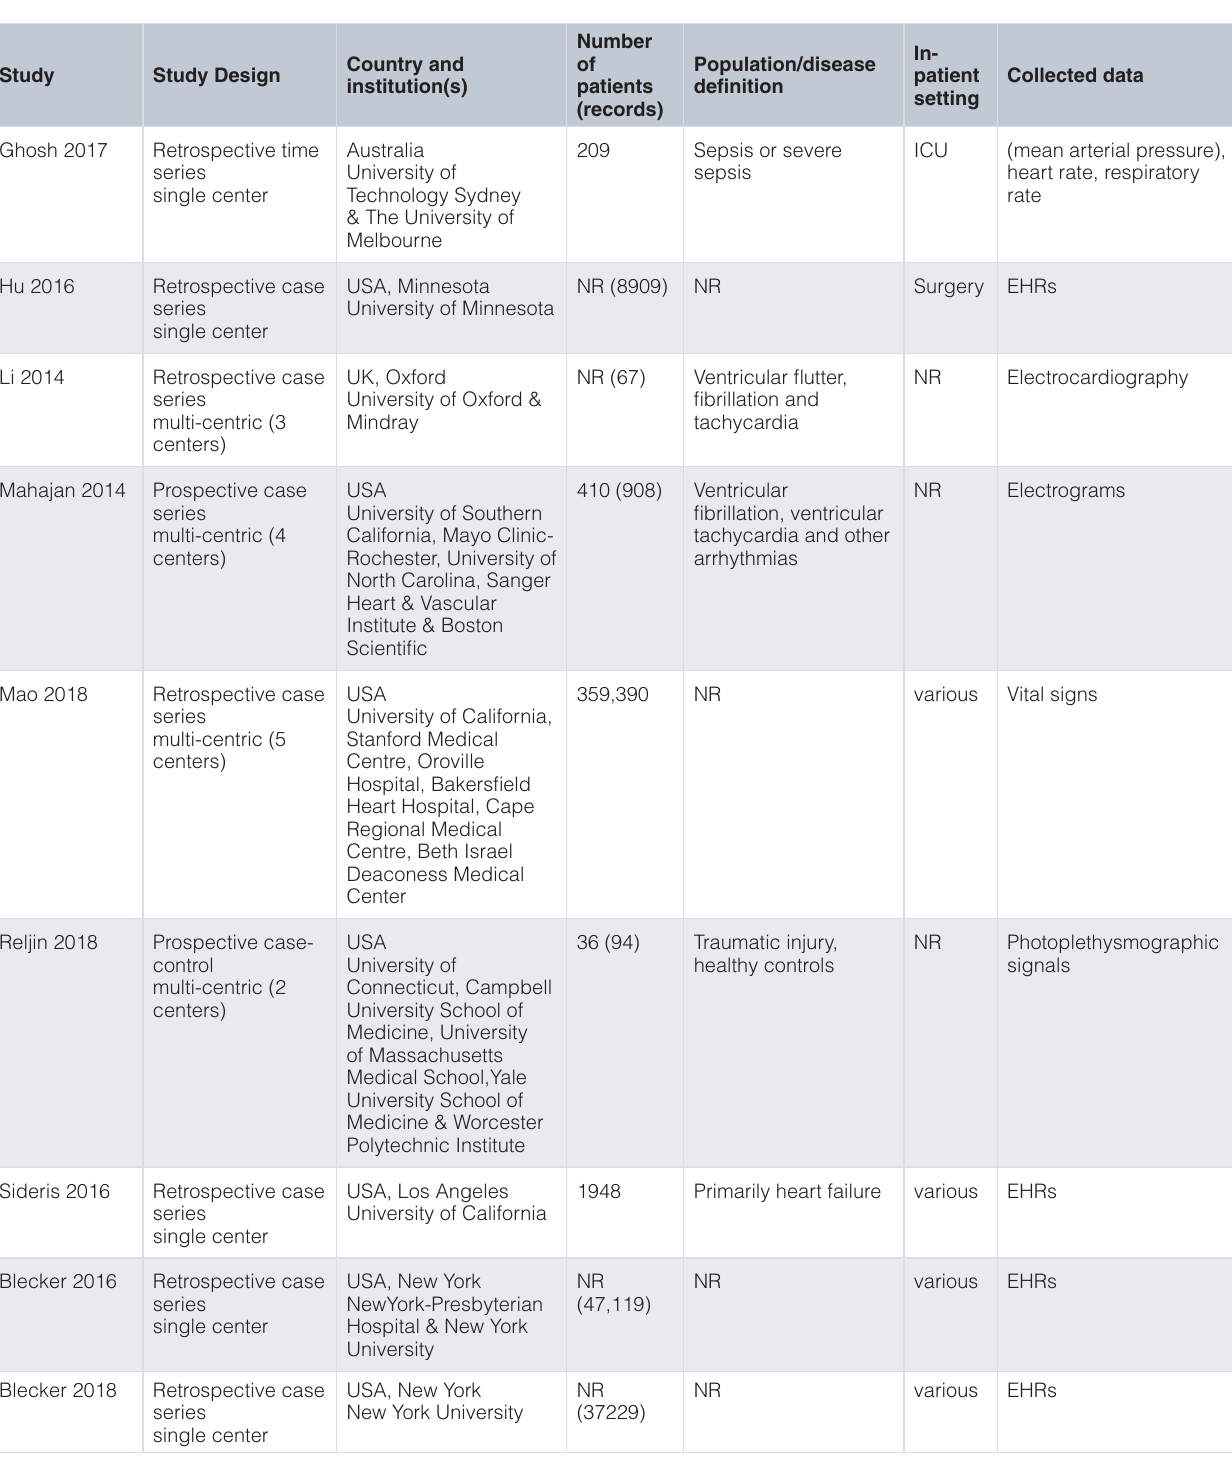
Table 2. Design aspects of published studies on shock.